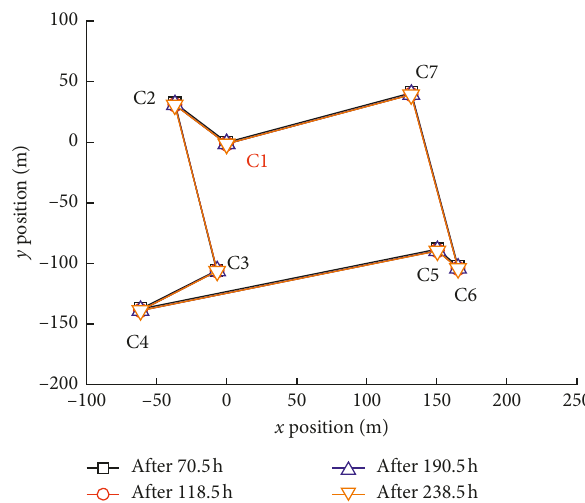
Figure 4: Aerial view in subsidence area of aeolian sand.